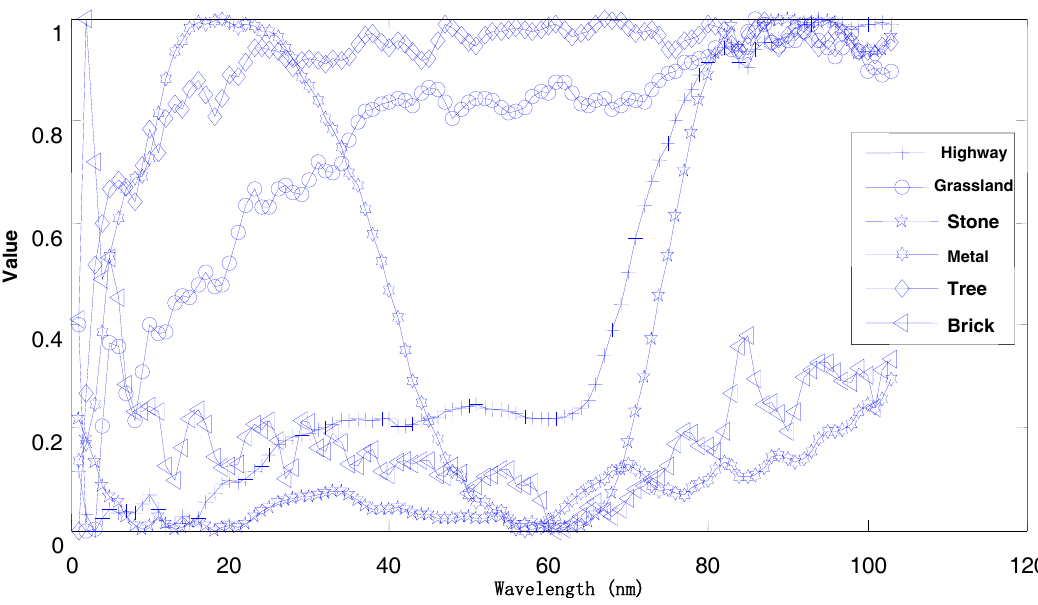
Figure 11. The high spectral data curve of the university of Pavia.